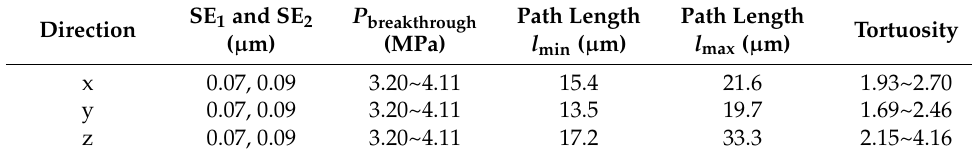
Table 3. Numerical calculation results for the Boom